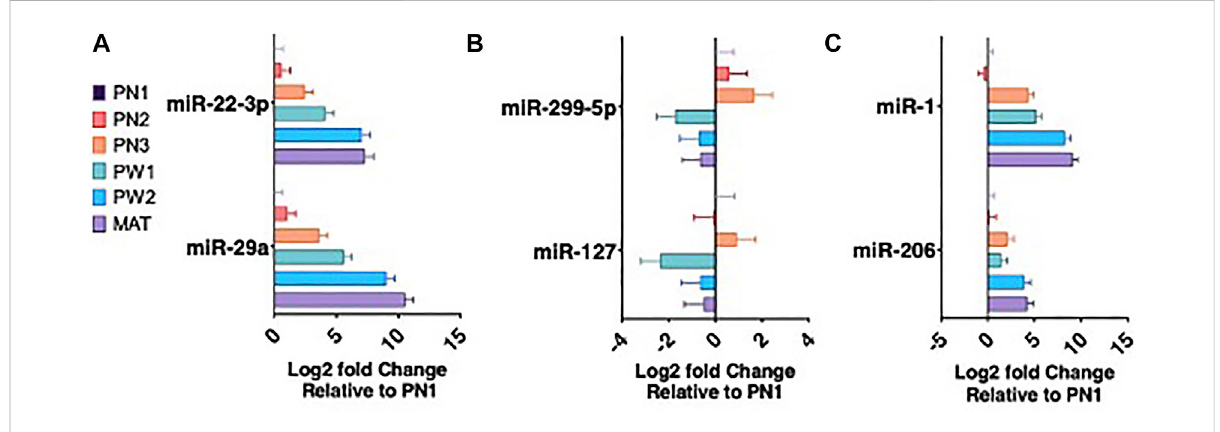
FIGURE 3 miRNA expression during six developmental time points. miRNA upregulated during development (A) . miRNA downregulated during development (B) . Muscle speci fi c miRNA expression (C)